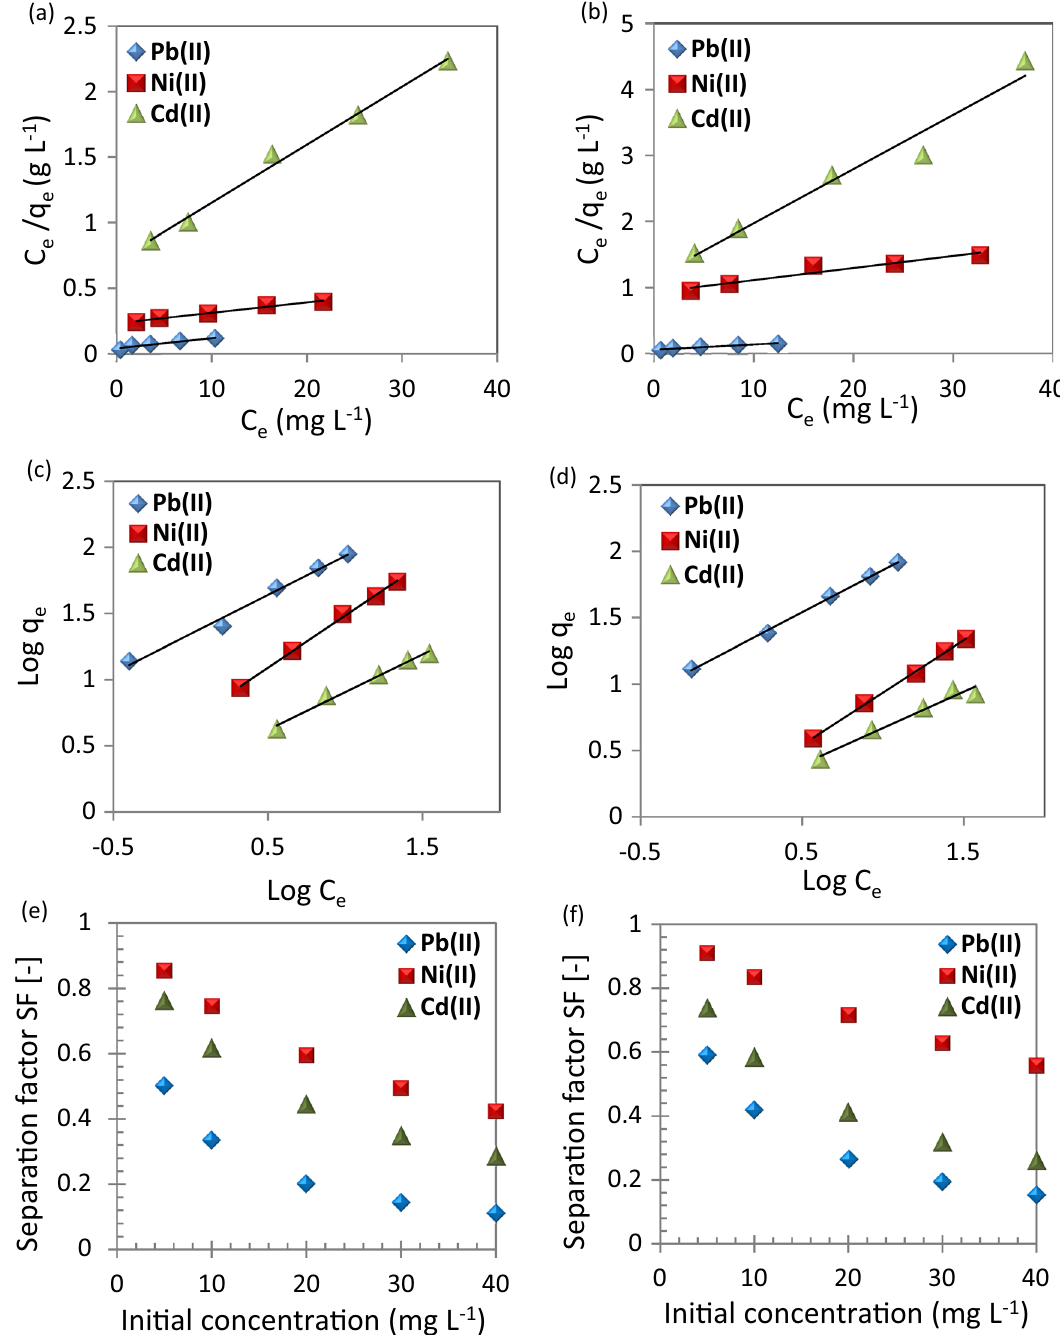
Figure 9. ( a,b ) Langmuir plots, ( c,d ) Freundlich plots, and ( e,f ) separation factor for the adsorption of metal ions; Pb(II), Ni(II), and Cd(II) using ( a,c,e ) CuO NPs-1 and ( b,d,f ) CuO NPs-2 at contact time: 60 min, dose: 0.33 g L −1 , and pH: